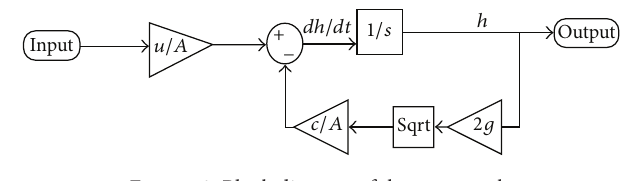
Figure 2: Block diagram of the water tank.